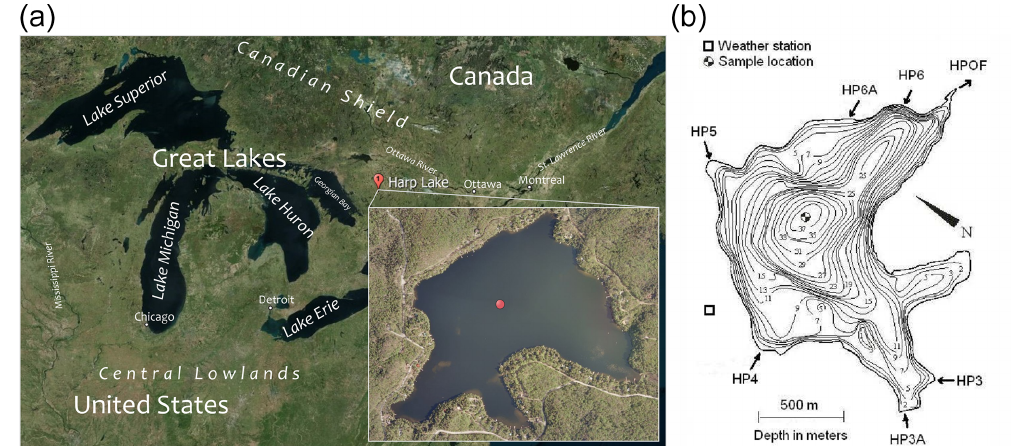
Figure 1. The location and morphometry of Harp Lake (HP3 to HP6A are the six inflows; HPOF is the lake outflow). Red circle indicates the position of the high-frequency monitoring buoy (45 ◦ 22 (cid:48) 44.88 (cid:48)(cid:48) N, 79 ◦ 8 (cid:48) 7.77 (cid:48)(cid:48) W). (a) Map data copyright 2017 by © Google, Maxar Technologies; (b) reprinted from Yao et al. (2014), copyright 2014 by Hydrol.